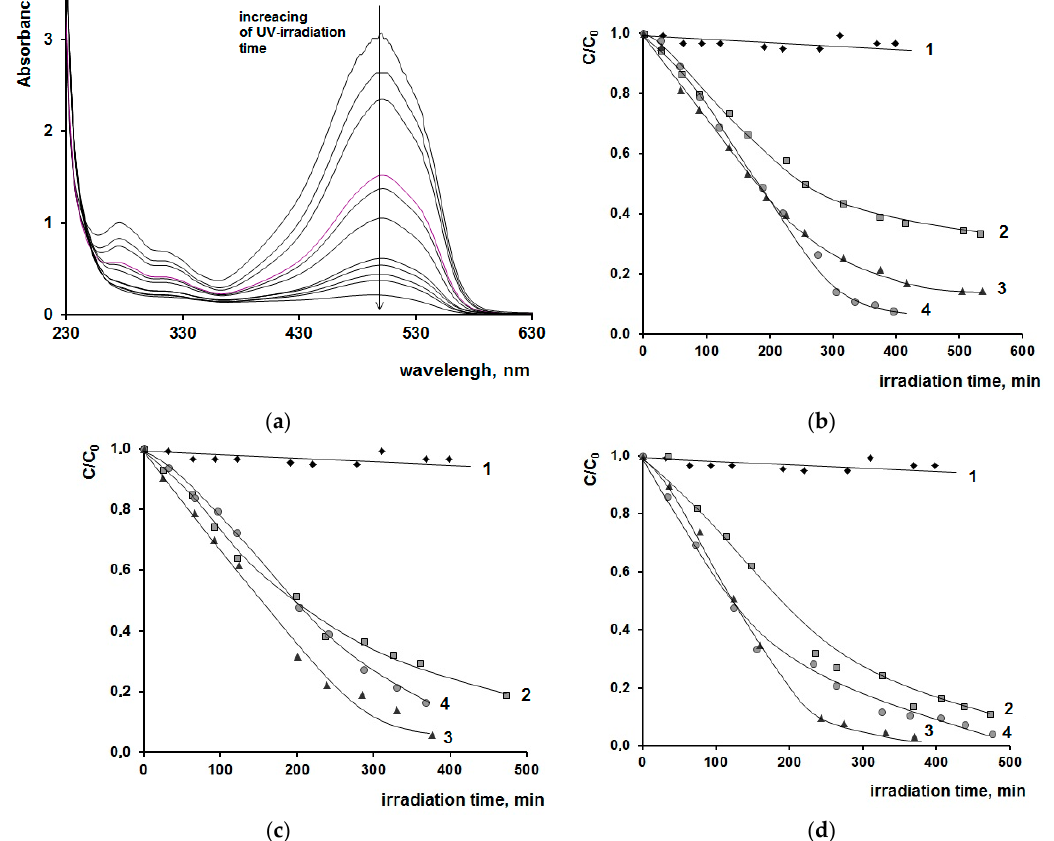
Figure 4. Photocatalytic properties of composites: ( a ) change in the absorption spectrum of MO aqueous solution with increasing time of its UV irradiation with the usage of copolymer of original composition [( ≡ TiO) n ]:[HEMA]:[M] + NPs of Ag as a catalyst; ( b – d ) a change in the MO concentration in the solution in time during its UV irradiation in the presence of composition materials with HEMA ( b ), BMA ( c ); and AN ( d ) units. Curve 1—«empty» experiment; curve 2—material with PTO without NPs; curve 3—PTO in the material is doped with gold NPs; and curve 4—PTO in the material is doped with silver